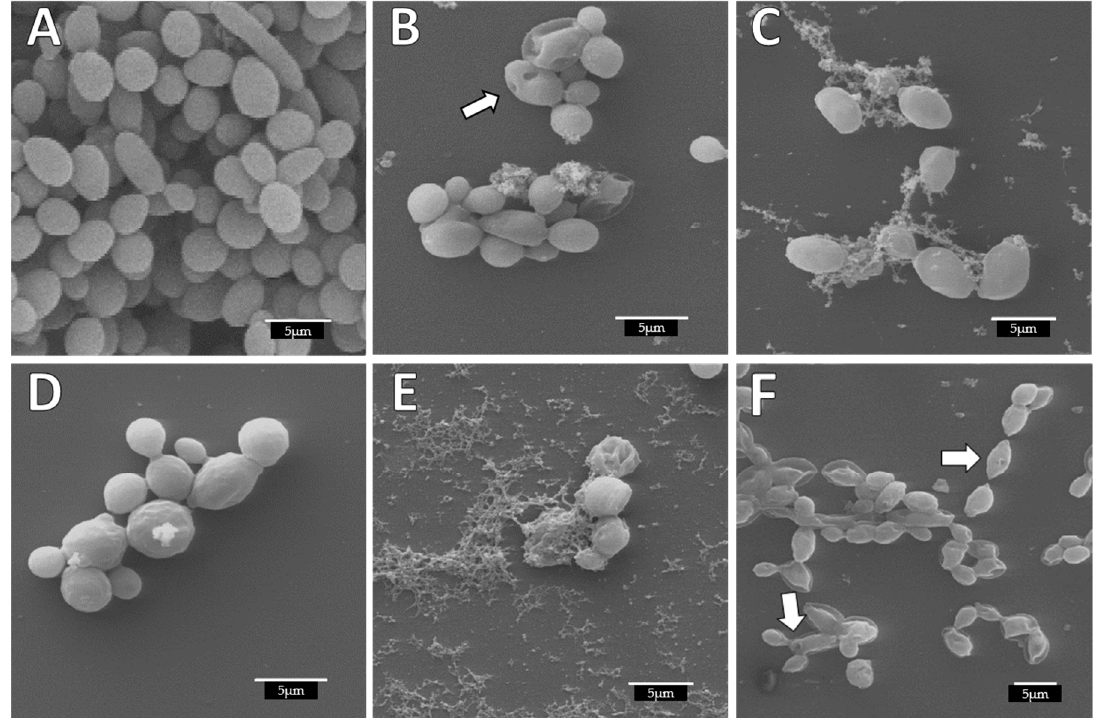
Figure 4. Alterations produced in C. albicans biofilm structure and cell morphology during the established biofilm-treatment observed by SEM. ( A ) Untreated; ( B ) 256 mg/L ArCO 2 G 2 (SNMe 3 I) 4 ( 2 ) dendron; ( C ) 32 mg/L AgNO 3 ; ( D ) 256 mg/L EDTA; ( E ) 32:32 mg/L combination ArCO 2 G 2 (SNMe 3 I) 4 ( 2 ):AgNO 3 ; ( F ) 256:32 mg/L combination ArCO 2 G 2 (SNMe 3 I) 4 ( 2 ):EDTA (white arrow: collapsed cells).